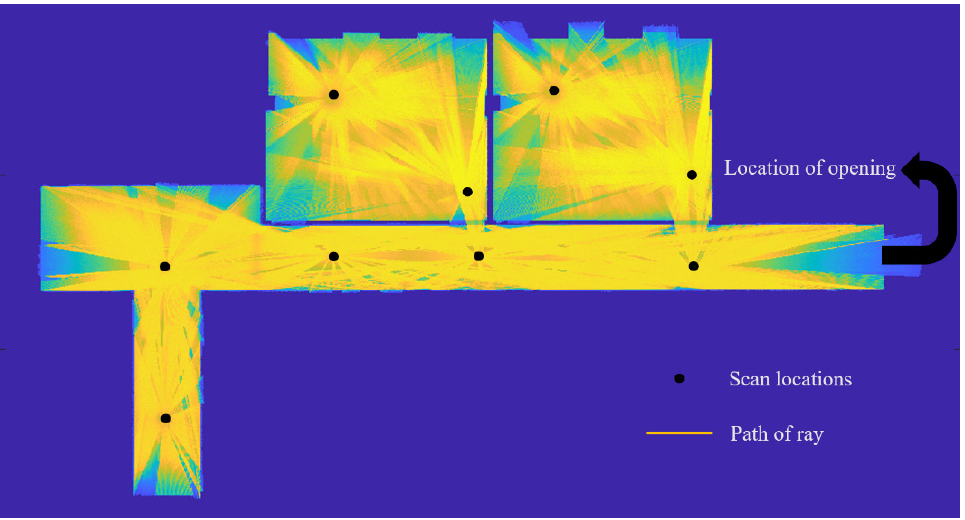
Figure 9. Refined 2D projection of the ray-casting results (i.e., 2D indoor area).